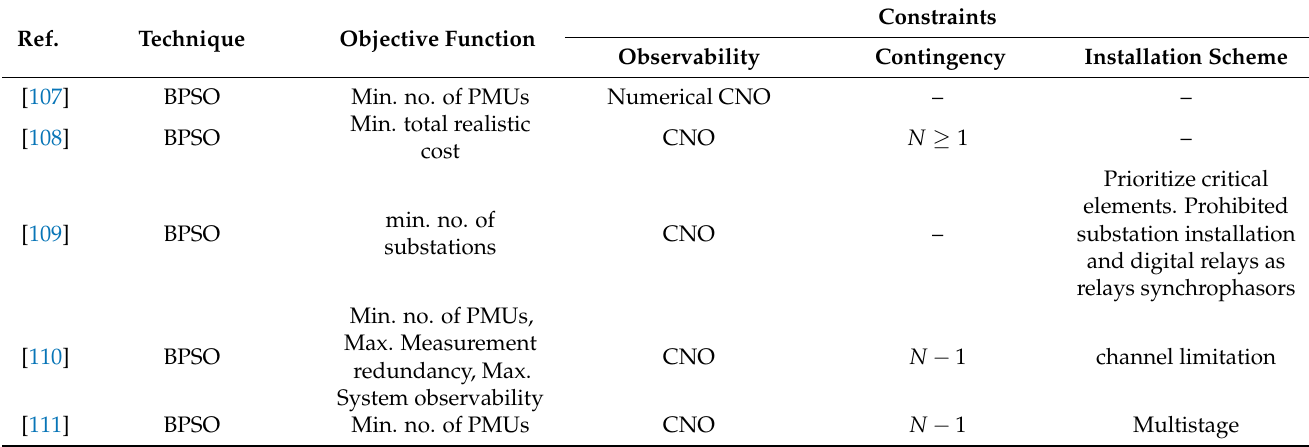
Table 4. A summary of PSO based OPP.